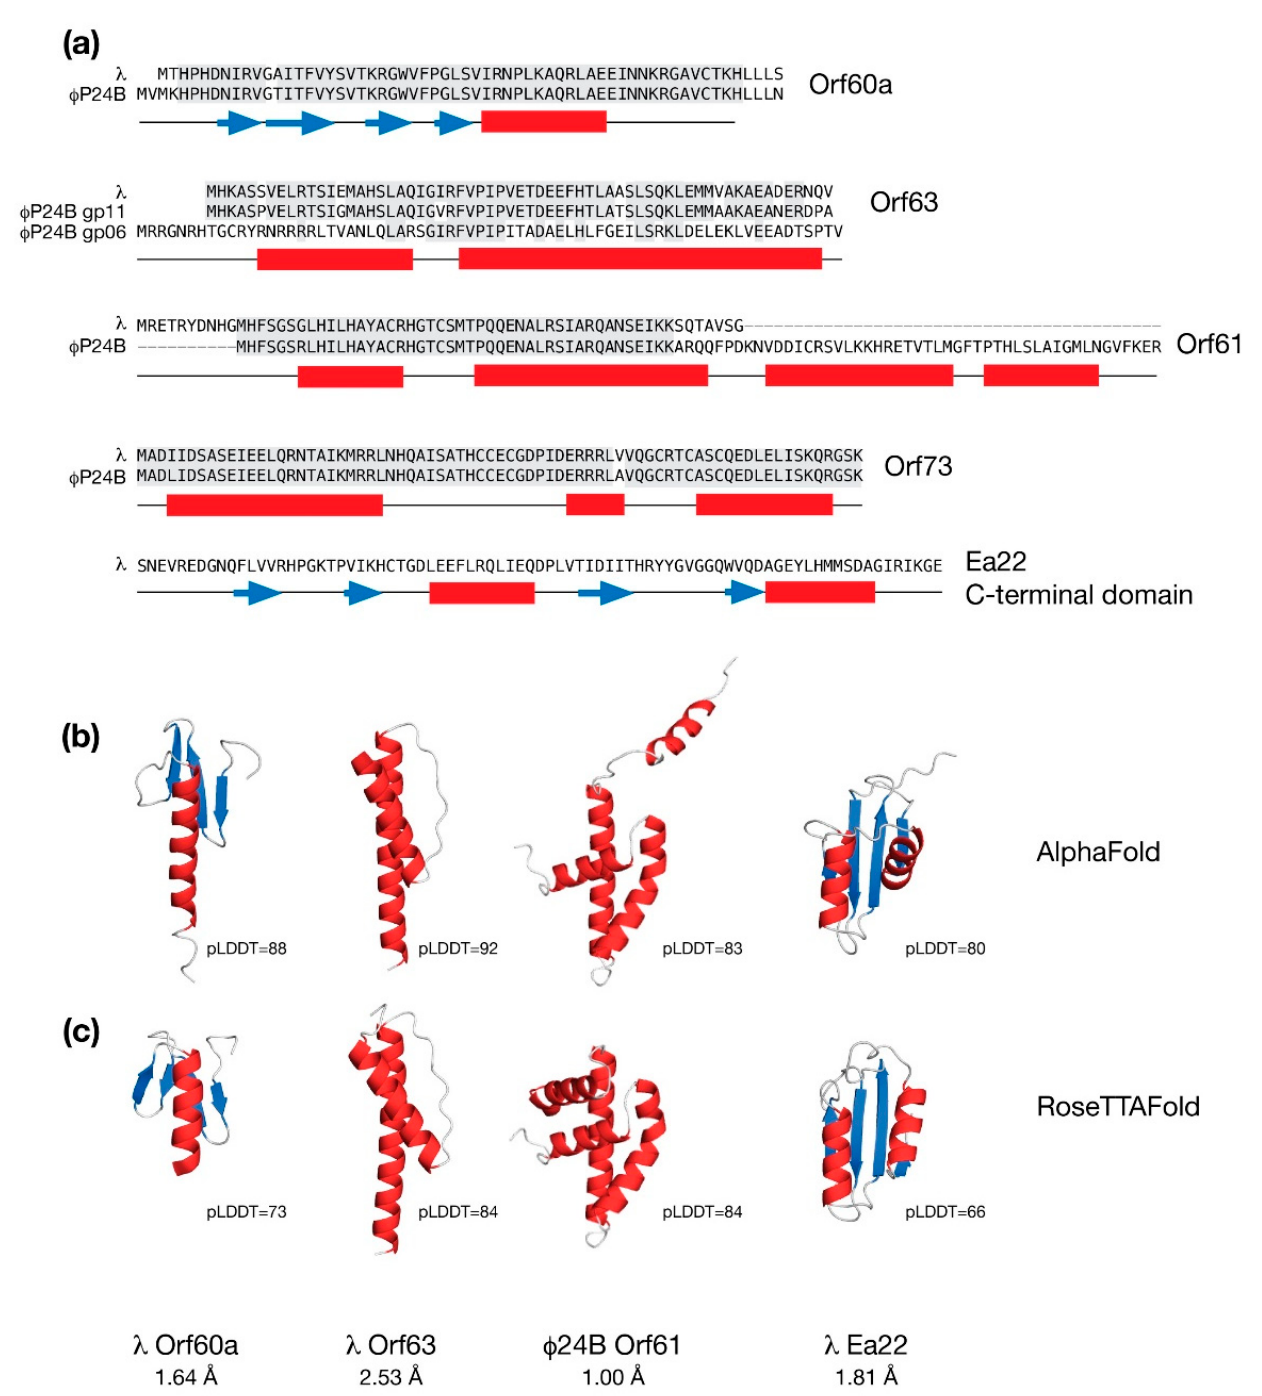
Figure 3. Molecular modeling the conserved exo-xis region proteins in their monomeric forms from bacteriophages λ and Φ 24 B . ( a ) Sequence alignments are shown for Orf60a, Orf63, Orf61, and Orf73. Identical amino acids shaded grey. There are two paralogs of Orf63 in Φ 24 B . Only the C-terminal domain of Ea22 is shown. The predicted secondary structure is presented below the sequences with helices in red and strands in blue. ( b ) Molecular models of selected exo-xis proteins by AlphaFold. ( c ) Molecular models of selected exo-xis proteins by RoseTTAFold. Structural similarity (as backbone RMSD) and accuracies (as pLDDT values) between the AlphaFold and RoseTTAFold models are indicated. Due to the structural dissimilarity, residues 1-23 are not included in the statistics of the Φ 24 B Orf61